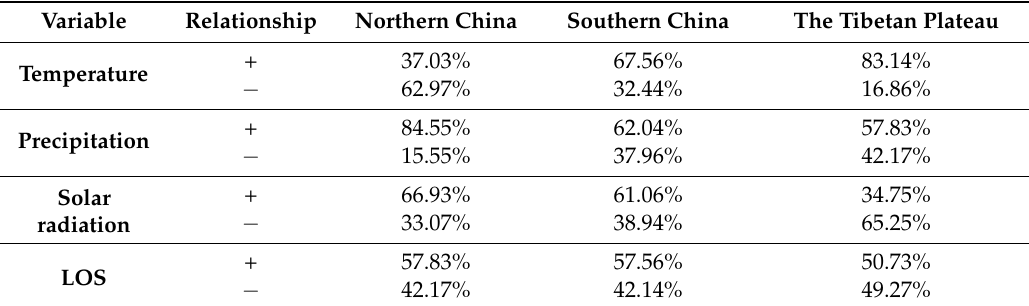
Table 1. Partial correlation between the Net Primary Productivity (NPP) and climatic factors as well as Length of Season